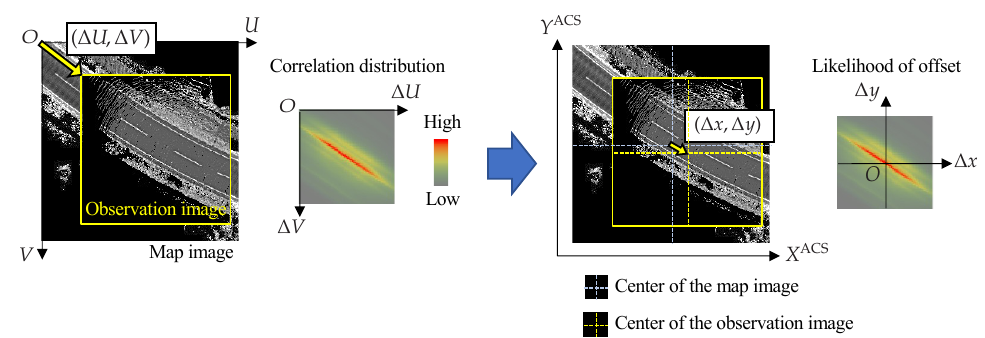
Figure 8. Correlation distribution and likelihood of offset.